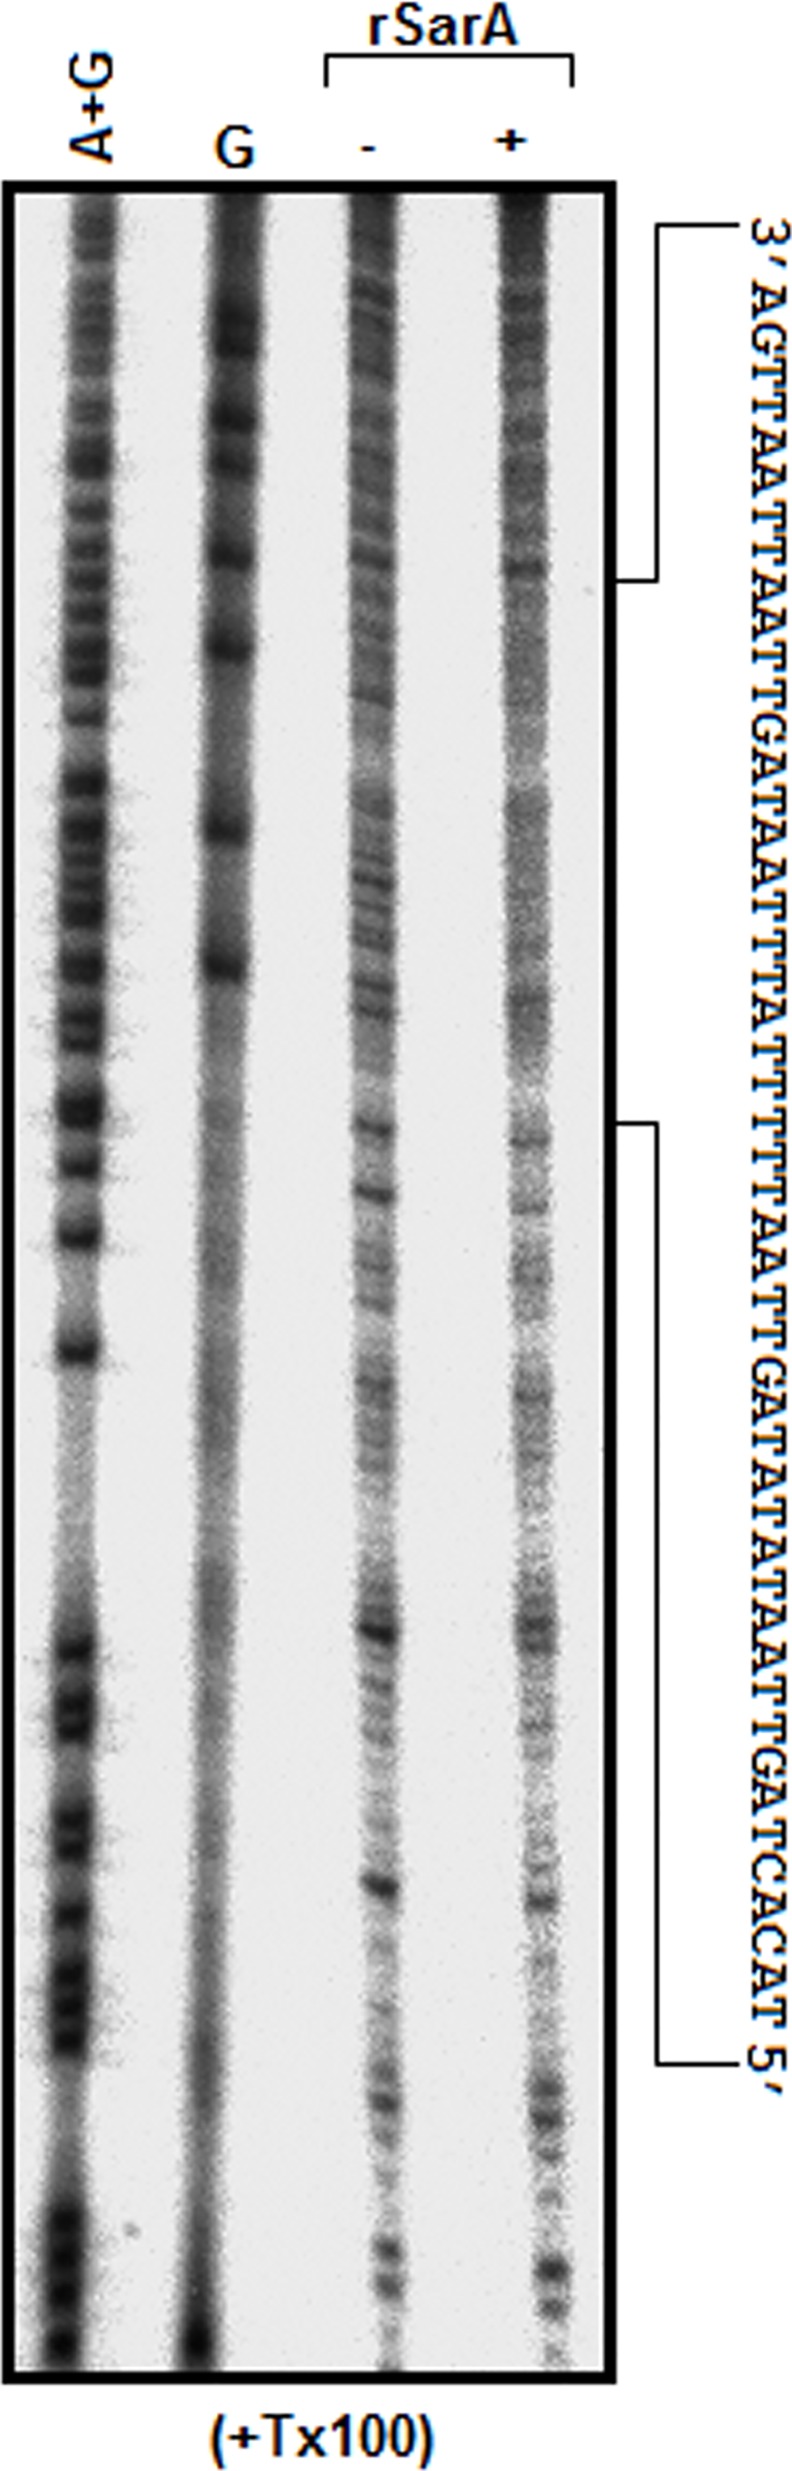
Autoradiogram of DNase I footprinting assay.The bottom strand labelled (with 32P) hla DNA was incubated with (+)/without (-) the saturating amount of rSarA followed by the digestion of the DNA with DNase I. The resulting DNA fragments, along with the G and A+G markers (made from the same labelled hla DNA by a standard method) were separated by a urea-8% PAGE. Sequence of the hla DNA protected by rSarA is shown at the right side of autoradiogram.